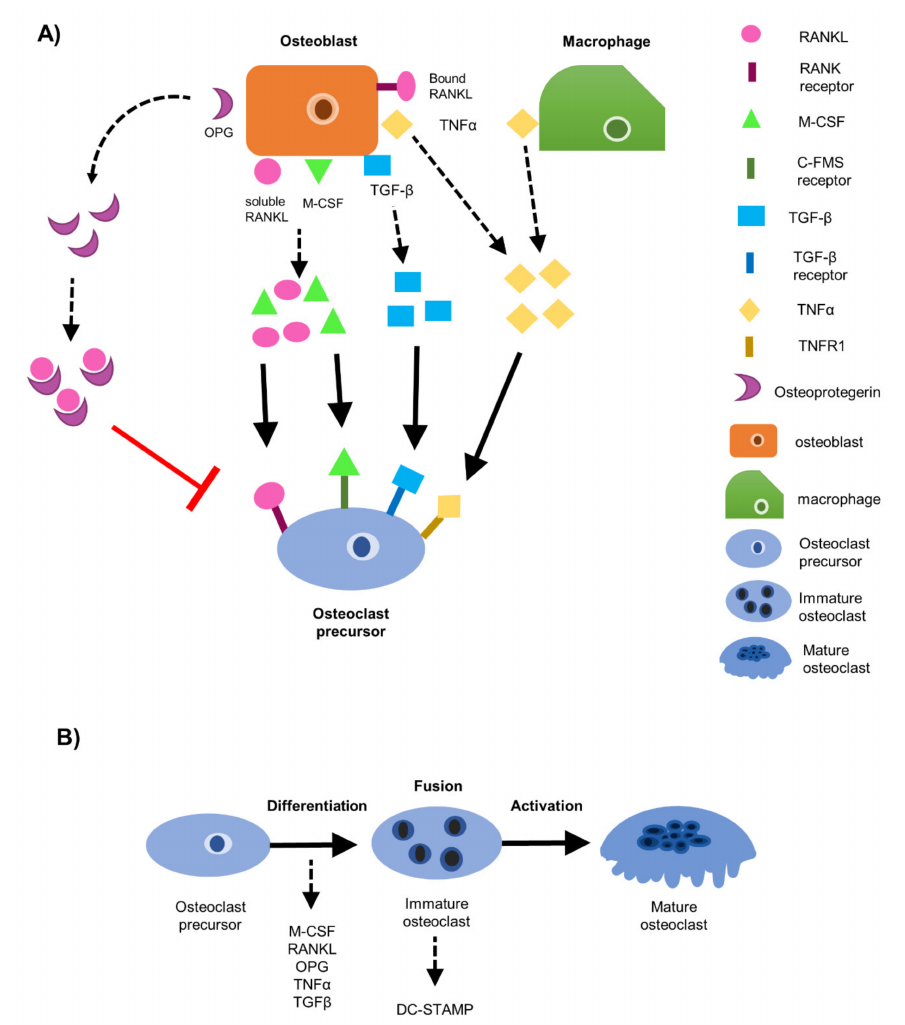
Figure 1. Osteoblasts are important regulators of osteoclast differentiation. ( A ) During bone re- modeling, osteoblasts recruit osteoclast progenitors to bone, whereby they secrete factors needed for osteoclast differentiation. Osteoblasts secrete macrophage-colony factor (M-CSF) and receptor activator of nuclear-factor kappa- β ligand (RANKL). The binding of M-CSF to the colony-stimulating factor-1 (C-FMS) receptor commits osteoclast progenitor cells to osteoclast linage and initiates osteo- clast differentiation. RANKL is also an important molecule for osteoclast differentiation. RANKL can exist in a bound form on osteoblasts or a soluble form secreted from osteoblasts. In this case, soluble RANKL is secreted from osteoblasts and binds the receptor activator of nuclear factor kappa- β (RANK) receptor on osteoclast progenitors, further initiating differentiation of pre-osteoclasts. Addi- tionally, osteoclastogenesis can be initiated by RANKL-independent mechanisms, including trans- forming growth factor-beta (TGF- β ) and tumor necrosis factor-alpha (TNF α ). TGF- β , secreted from osteoblasts, binds to the TNF- β receptor complex on osteoclast progenitor cells to independently initiate osteoclast differentiation. TNF α , secreted from osteoblasts or macrophages, binds to the tumor necrosis factor receptor 1 (TNFR1) on osteoclast progenitor cells and can also independently initiate osteoclast differentiation. To combat excess bone degradation, osteoblasts secrete osteoprote- gerin (OPG), a decoy receptor for RANKL. OPG acts as a decoy receptor, where it can bind soluble RANKL. In turn, soluble RANKL is inhibited from binding to the RANK receptor on osteoclast progenitors. In this way, osteoclastogenesis in inhibited. ( B ) Osteoclast differentiation is regulated by the expression of M-CSF, RANKL, OPG, TNF α , and TGF- β . Once osteoclast differentiation is initiated, osteoclast progenitors fuse together with the help of the key osteoclast fusion regulator dendrocyte expressed seven transmembrane protein (DC-STAMP) to become immature osteoclasts. Upon activation, immature osteoclasts become mature osteoclasts capable of resorbing